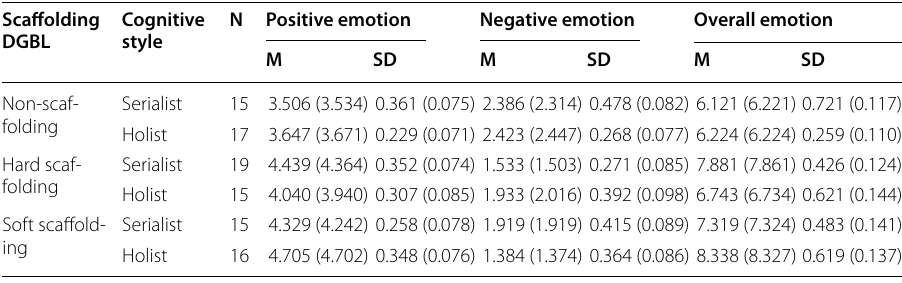
Number of Serialist and Holist 49 and 48; Data in the parentheses was adjusted mean and adjusted standard deviation =